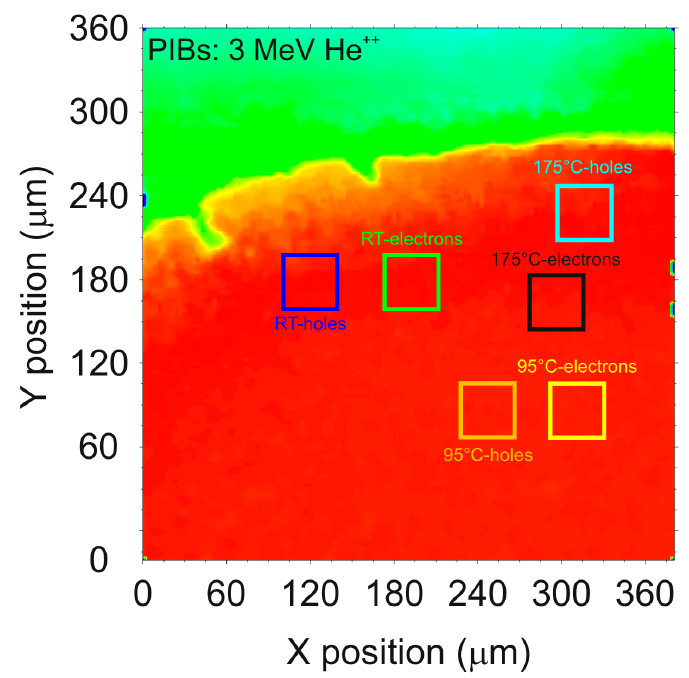
Figure 6. IBIC map of the 500 µ m diamond detector biased at +225 V under irradiation with 3 MeV He ++ . The color squares in the pristine region delimit the selected regions used for the characterization where the operating temperature and polarity were set to a fixed value.